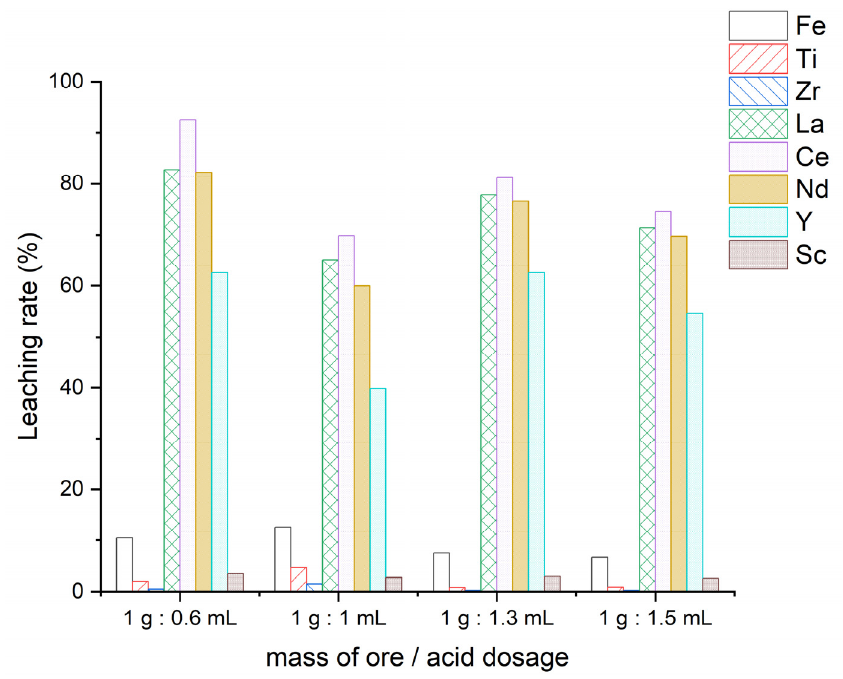
Figure 10. Leaching rate of iron, zirconium, lanthanum, cerium, neodymium, yttrium, and scandium, varying the acid dosage. Experimental conditions for baking: 1 g of ore; T = 400 ◦ C; 2 h. Experimental conditions for water leaching: solid-liquid ratio = 1/10; t = 2 h; under magnetic stirring.